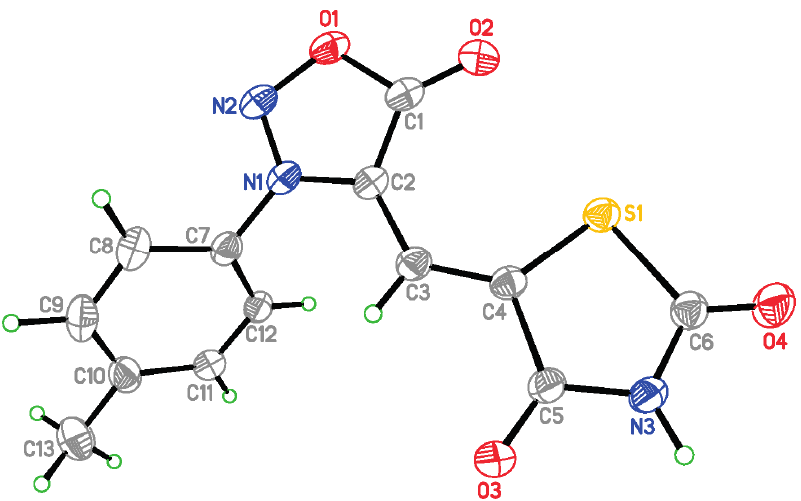
Figure 1. ORTEP drawing of 5-[3-(4-methylphenyl)sydnon-4-ylmethylene]thiazolidine-2,4- dione ( 4b